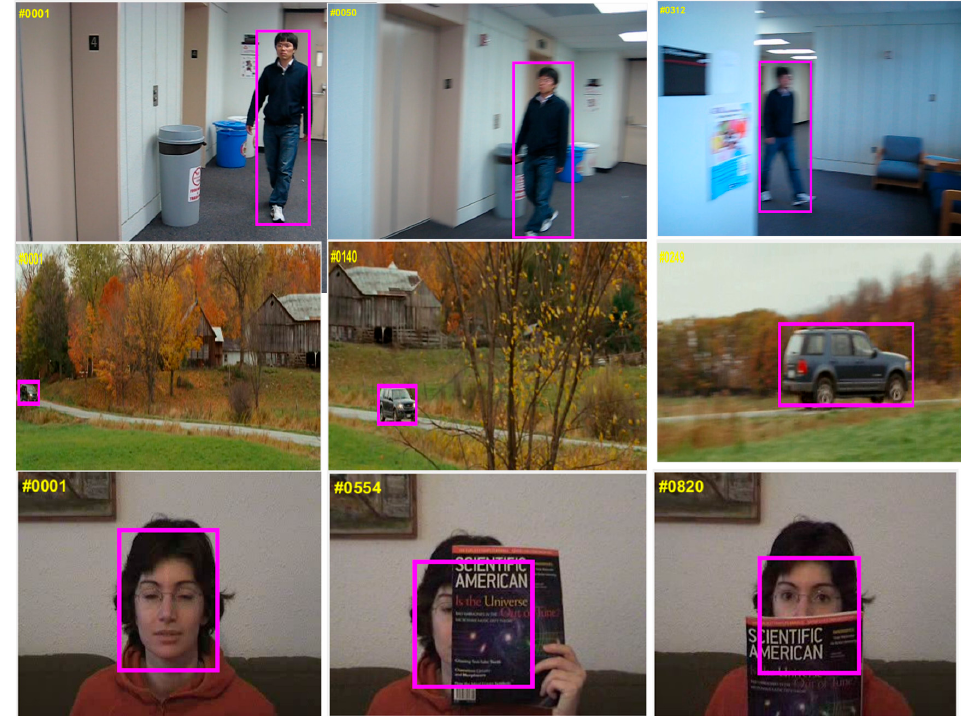
Figure 1. Challenging scenarios in visual object tracking (VOT). The first row shows motion blur in an image sequence. The second row shows the scale variation of the target. The third row shows heavy occlusion of the target. Pictures in the figure are part of OTB-100 dataset [26].